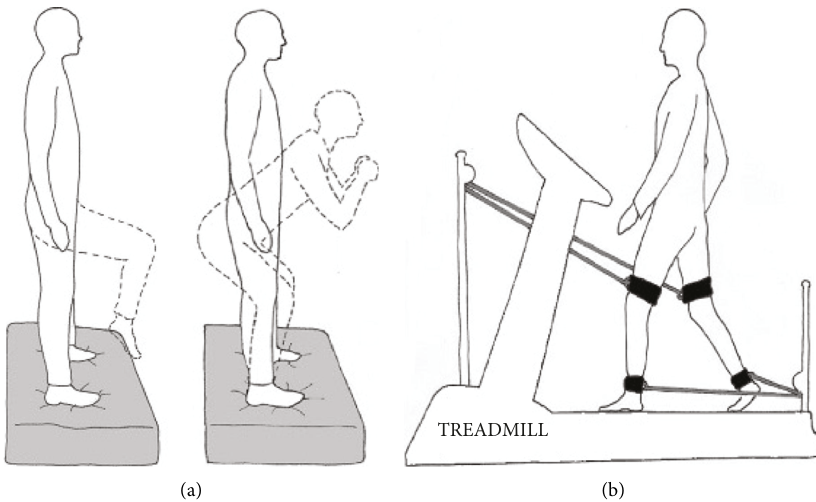
Figure 1: (a) Exercises performed by the stability resistance training (SRT) group. Participants carried out strength exercises on a balance- pad (grey). (b) Exercises carried out by the gait resistance training (GRT) group. Participants walked on a treadmill while elastic cables (gray) with cuffs (black) were attached to their legs to provide resistance during